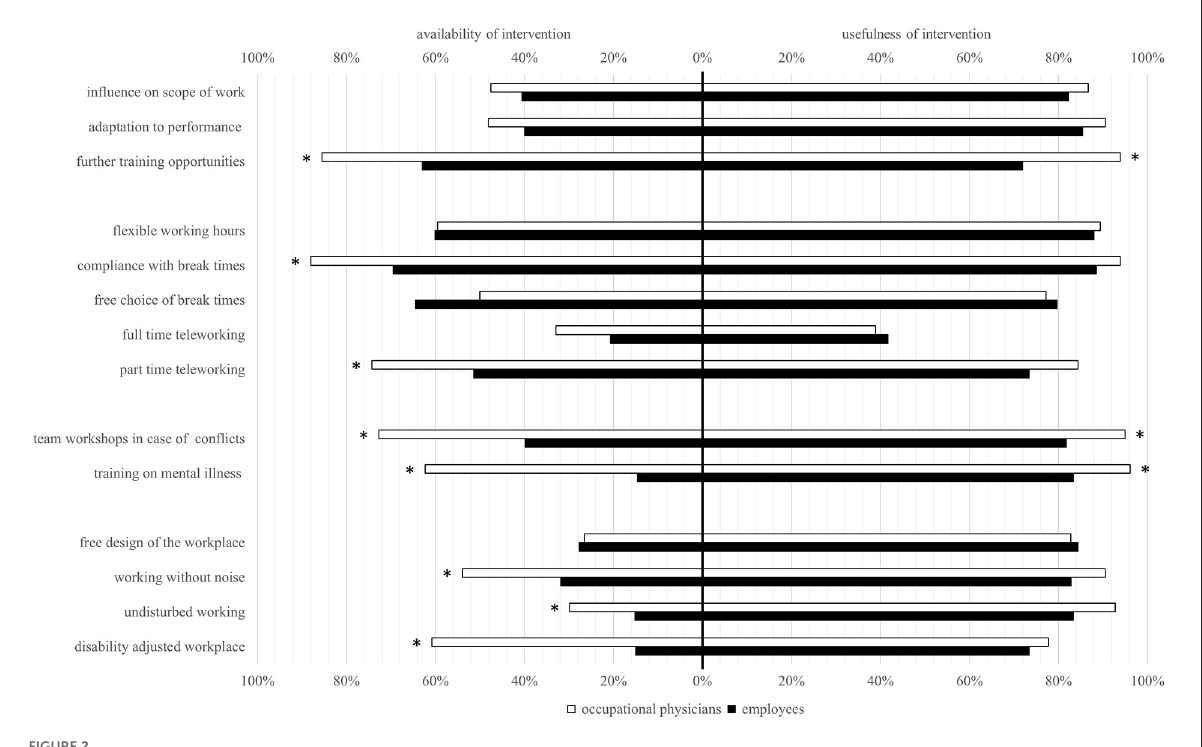
FIGURE2 Availability and usefulness of workplace-based interventions.